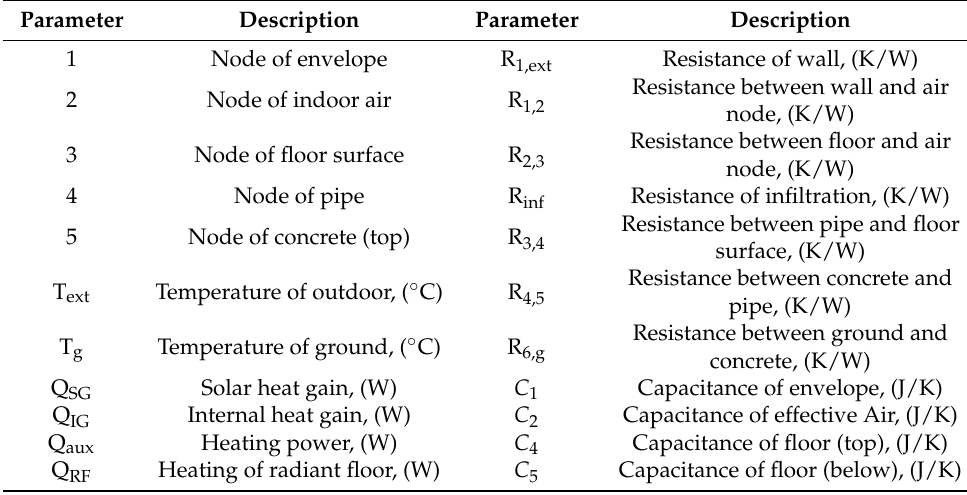
Figure 14. Calibration of RC thermal network model with measured data, zones with hydronic radiant floor system and convective system. Table 4 provides an overview of the thermal network model parameters: Table 4. Description of RC thermal network model parameters